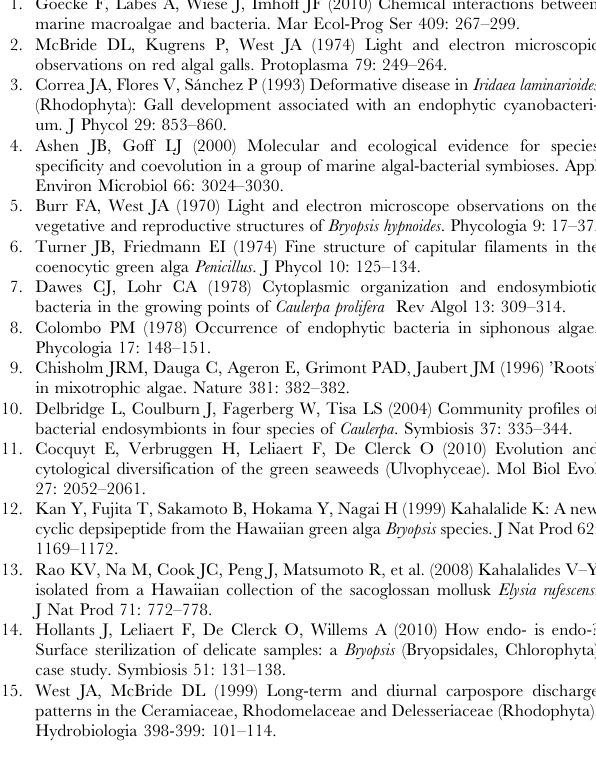
Figure S1 A wide-range maximum likelihood tree showing the phylogenetic positions of endophytic clones and DGGE bands. Phylogenies were inferred from 16S rRNA gene sequences determined in this study (in bold), BLAST hits (see Table 1), Bacteroidetes, Proteobacteria and Mollicutes type strains, and algae-associated bacteria described in the literature (see Supplementary Table S2). The tree was generated in PhyML according the HKY + G4 algorithmic model. Bootstrap values above 50% are indicated at the branch nodes and the scale bar shows 10 nucleotide substitutions per 100 nucleotides. Asterisks denote sequences previously isolated from micro * - and macroalgae**.